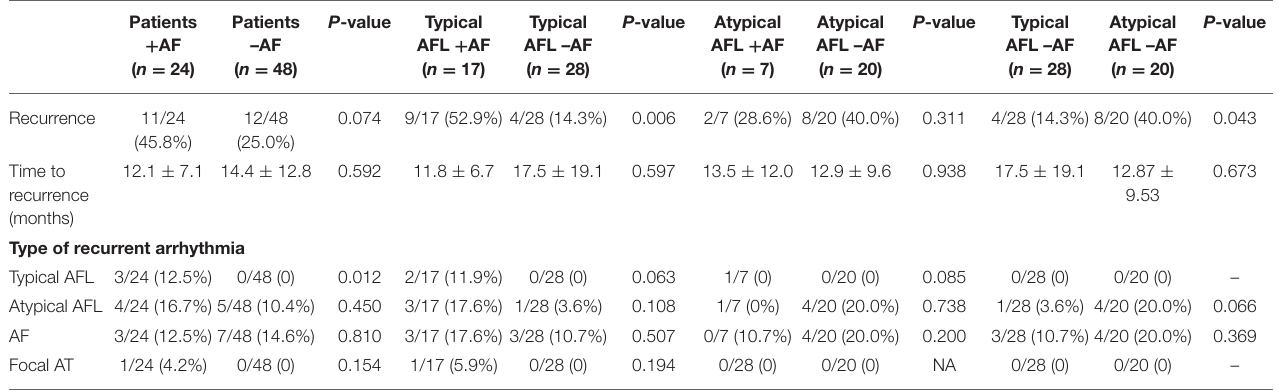
TABLE 4 | Analysis of ablation outcomes among the different subgroups. Patients + AF